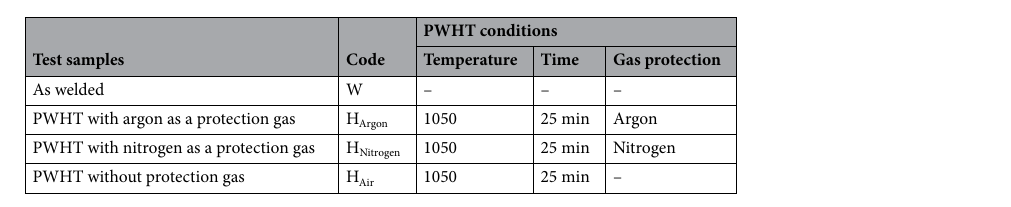
Table 3. Proposed post weld heat treatment